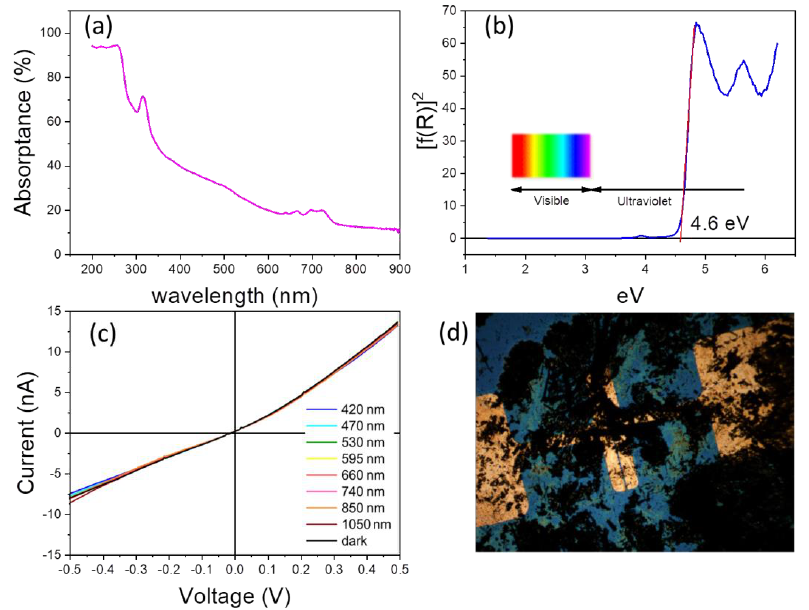
Figure 5. ( a ) Absorptance vs. wavelength of the incident radiation and ( b ) Kubelka – Munk trans- formed diffuse reflectance spectrum for CH 3 NH 3 CdBr 3 . ( c ) Photocurrent measurements in 420 – 1050 nm wavelength range and ( d ) optical image of optoelectronic